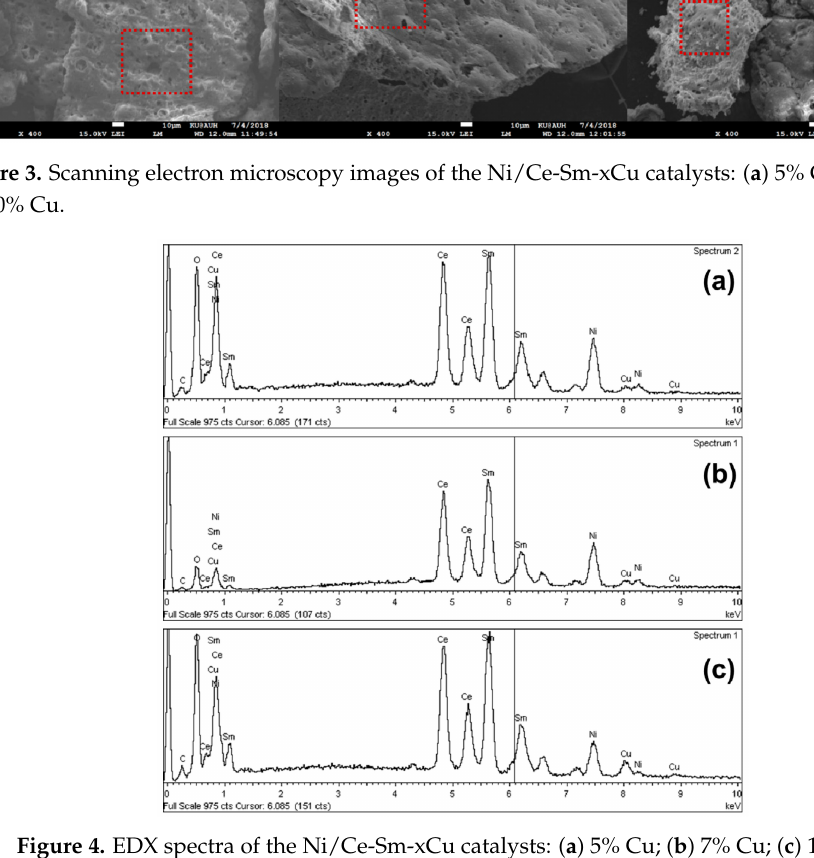
Figure 4. EDX spectra of the Ni/Ce-Sm-xCu catalysts: ( a ) 5% Cu; ( b ) 7% Cu; ( c ) 10%